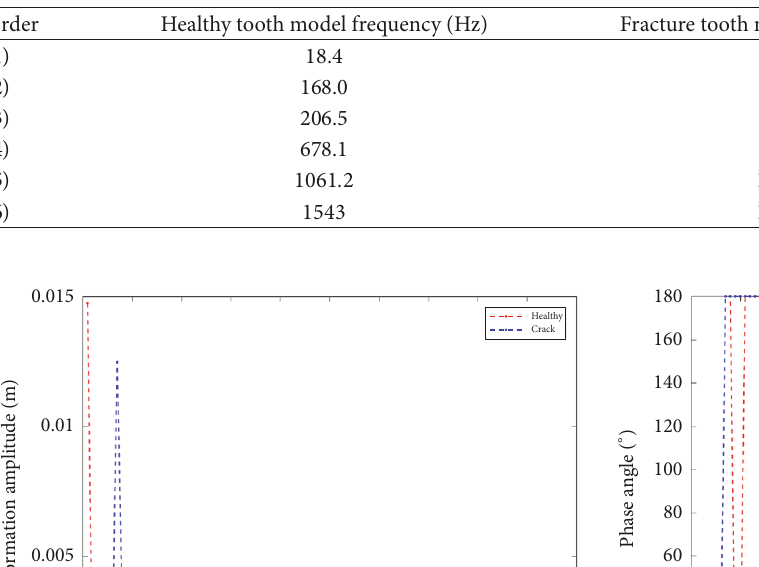
Table 2: Natural frequency.